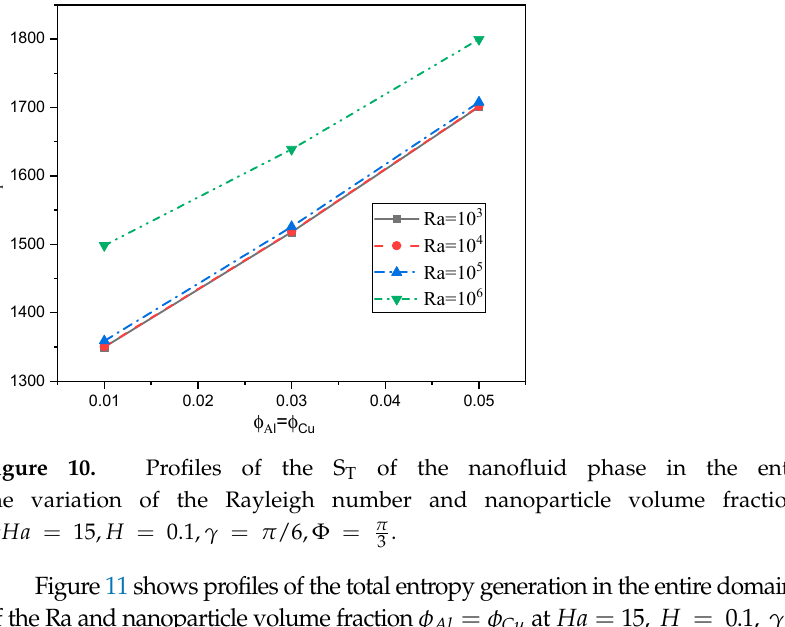
. . (cid:2871) (cid:2871)